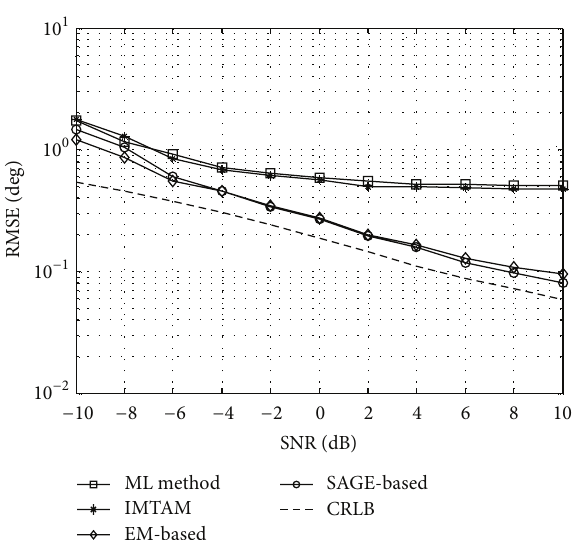
Figure 6: The average number of iterations needed for convergence against